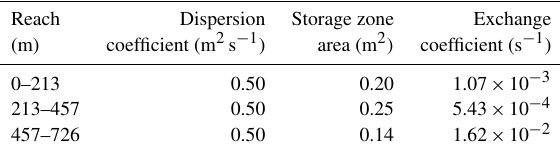
Table 15. Simulation parameters related to test case 6.